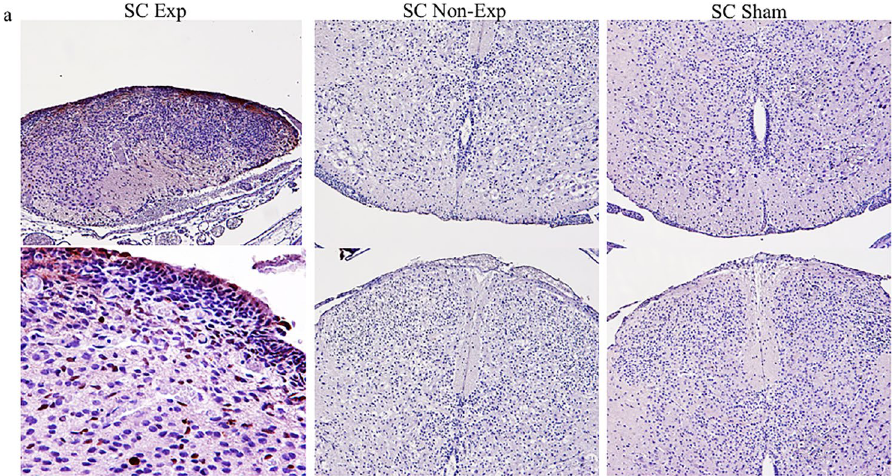
Figure 9. Cleaved-caspase 3 expression in exposed spinal cord (sc) in spina bifida aperta at E20. Cleaved- caspase 3 immunoreactive cells in the spinal cord sections (top row 20 × and bottom row 40 × ). Increased expression seen in exposed spinal cord compared with no expression in unexposed spina bifida and sham spinal cords at